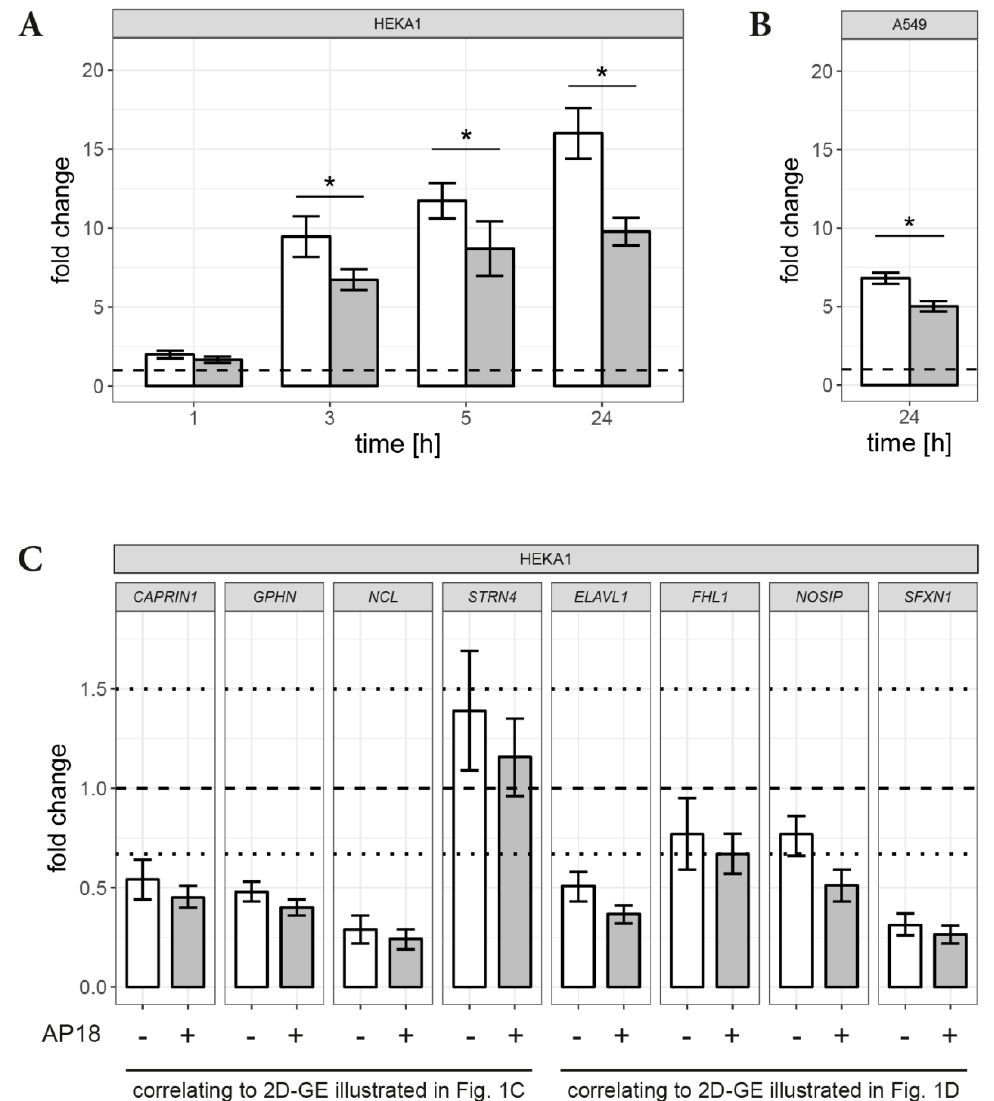
Figure 3. RT-qPCR measurements for potentially SM-affected and TRPA1-regulated genes. mRNA levels of ( A ) HSPA6 in HEKA1 cells, ( B ) HSPA6 in A549 cells and ( C ) CAPRIN1 , ELAVL1 , FHL1 , GPHN , NOSIP , NCL , SFXN1 and STRN4 in HEKA1 cells were analyzed 24 h after 600 µM SM exposure by RT-qPCR. White bars indicate the fold change values after SM exposure while grey bars illustrate the effect of 2 µM AP18 pre-incubation on mRNA levels. The dashed lines represent normalized levels of the control samples and dotted lines indicate ±1.5-fold change ranges. Significant differences ( p < 0.05) are displayed by asterisks (*). Error bars represent the 95% confidence intervals. Data are derived from independent biological experiments ( n = 3). Gene names correspond to the following proteins: Caprin-1 ( CAPRIN1 ), ELAV like protein 1 ( ELAVL1 ), Four and a half LIM domain protein 1 ( FHL1 ), Gephyrin ( GPHN ), Nitric oxide synthase interacting protein ( NOSIP ), Nucleolin ( NCL ), Sideroflexin 1 ( SFXN1 ) and Striatin 4 ( STRN4 ).